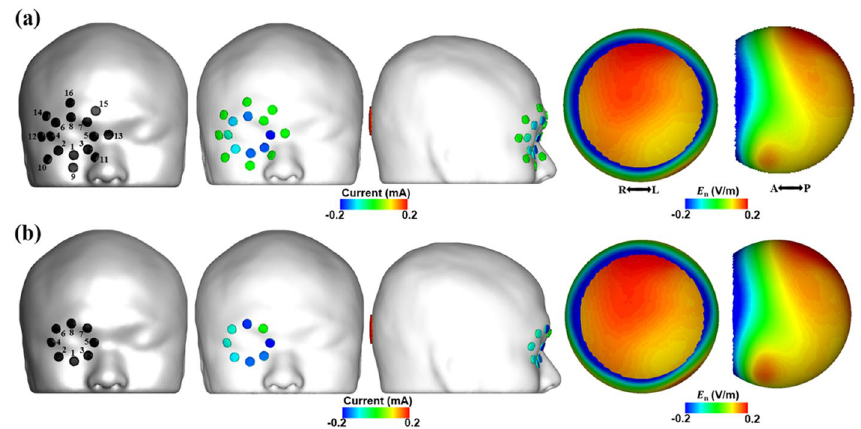
Figure 5. Injection current patterns and electric field distributions on the retinal surface when employing ( a ) electrode montage with 16 active electrodes, and ( b ) proposed electrode montage with eight active electrodes. The electrode numbers were marked next to the electrode locations. E n represents the electric field component perpendicular to the retina surface.